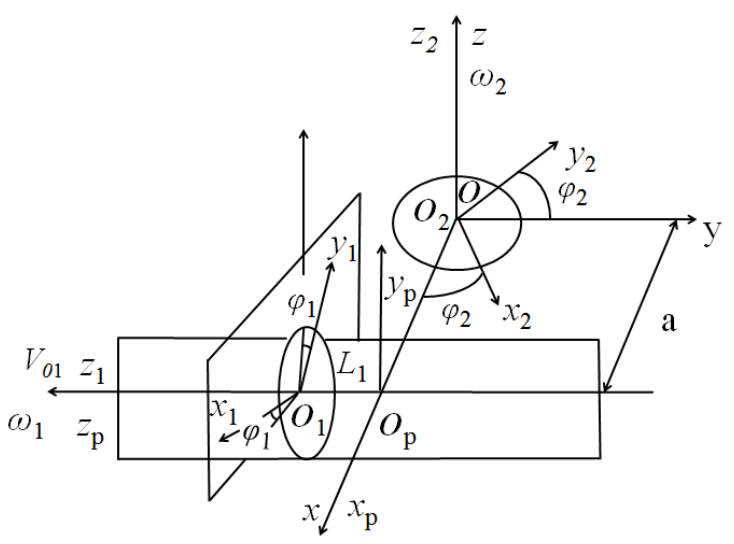
Figure 3. Coordinates of transmission.